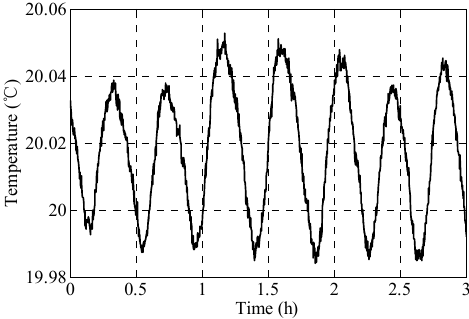
Figure 8. The temperature in the chamber.